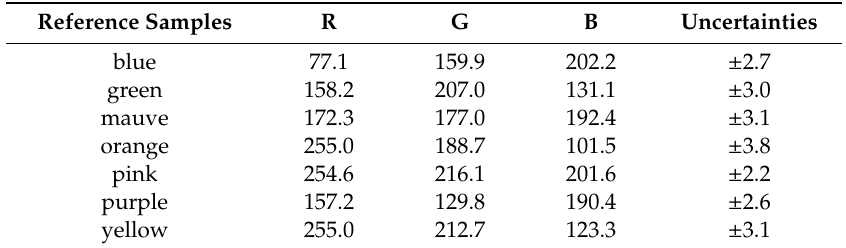
Table A4. Database of CaliPhoto RGB values for the coloured paper displayed in Figure A10. Uncertainties are given by 256 × ∆